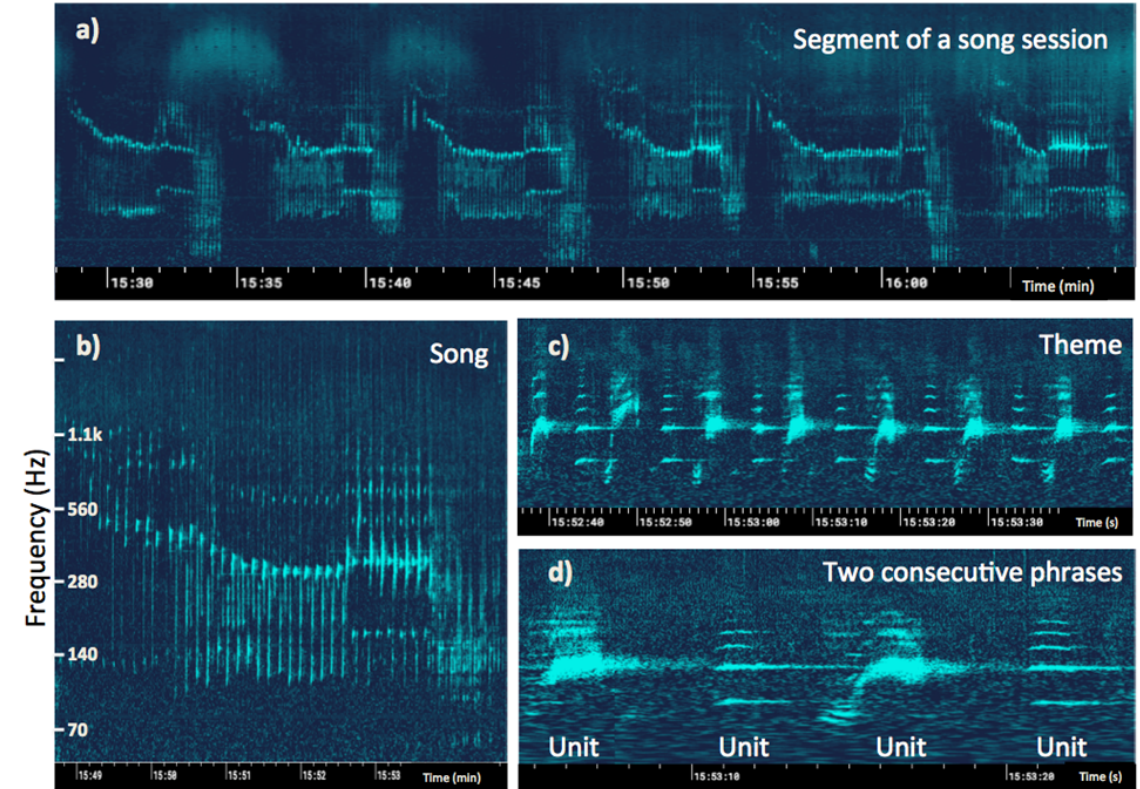
Structural Regularities Produced by a Singing Humpback Whale in